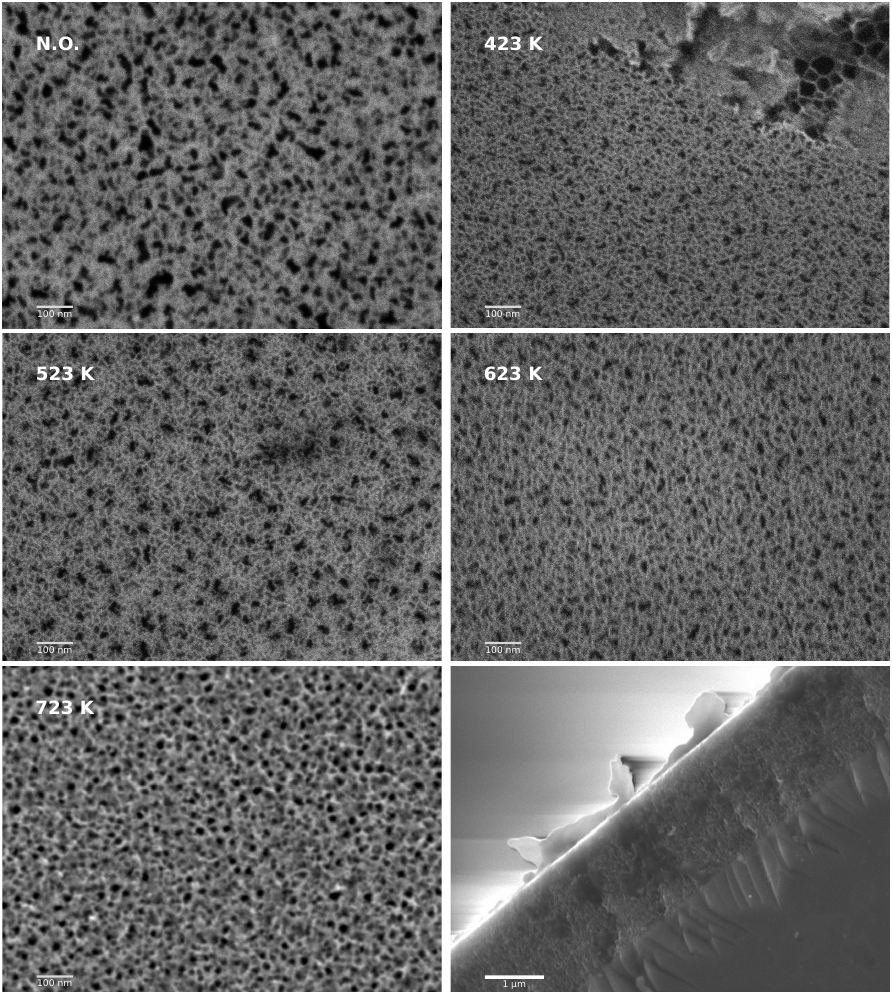
Figure 2. SEM images of samples oxidized at different temperatures given in the upper left and an image of the cross-section of a sample ( bottom right